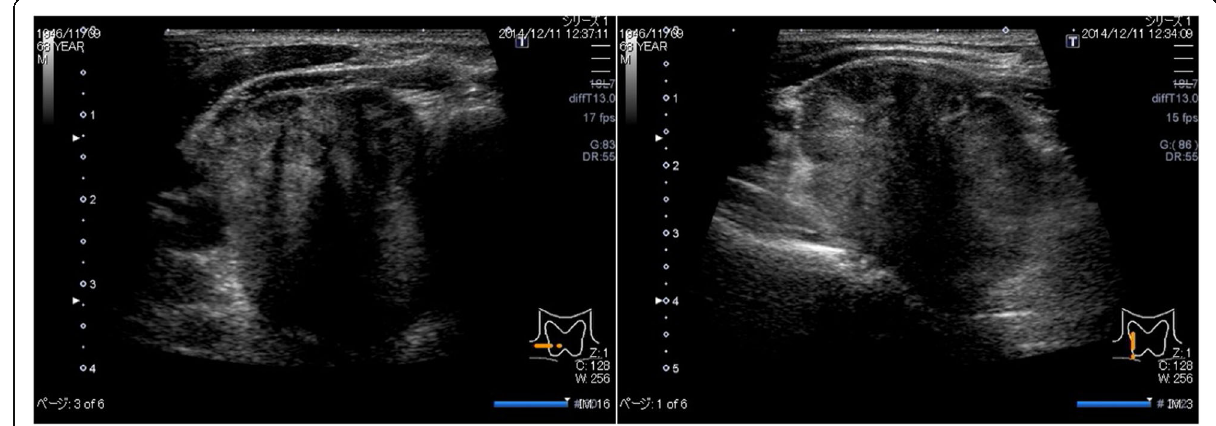
Fig. 1 Ultrasound findings. A hypoechoic area of 4.7 × 3.4 cm with an irregular margin and heterogeneity was